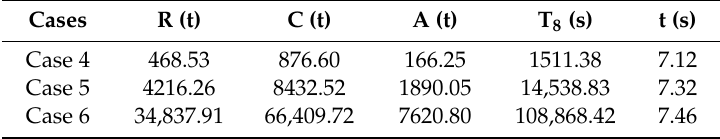
Table 7. Run time in different configurations for 2-D Dam Break with a rectangular obstacle downstream.